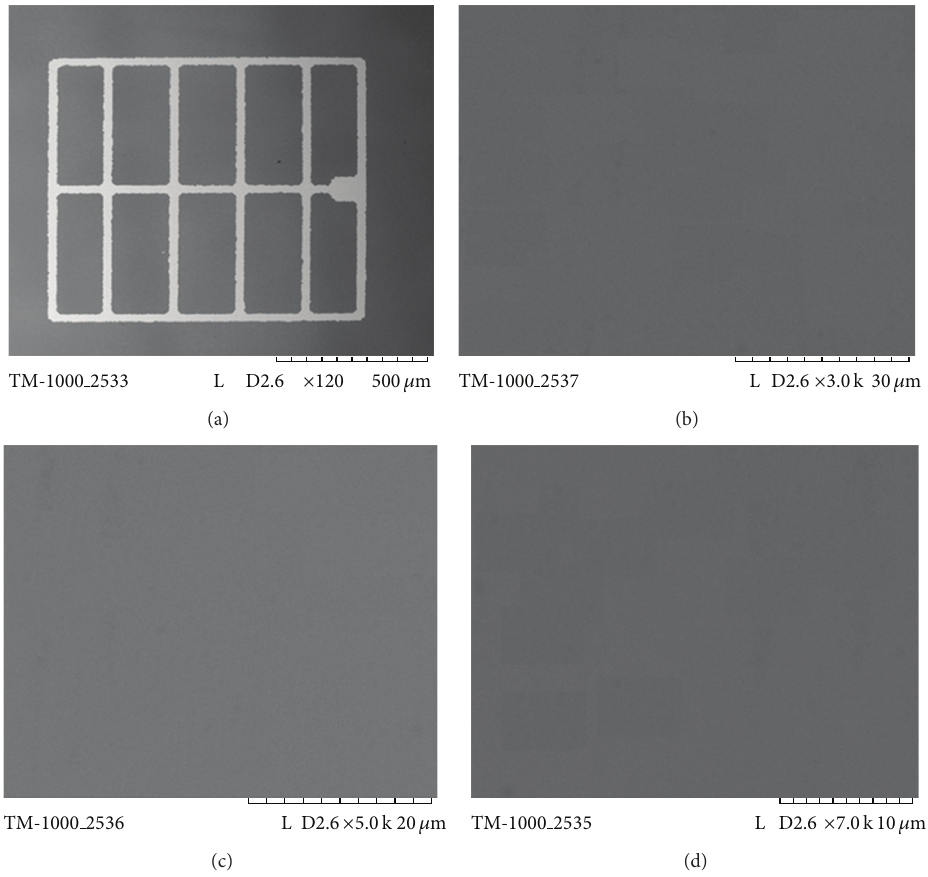
Figure 8: SEM images of the TF cell after the thermal shock test; (a) electrode pattern for the TF-cell; surface morphology images of the TF cell with amplification factors of (b) 3000 × , (c) 5000 × , and (d) 7000 ×